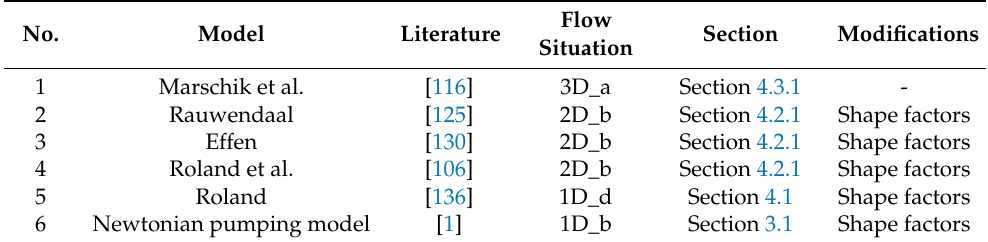
Table 6. Overview of the three-, two-, and one-dimensional modeling approaches